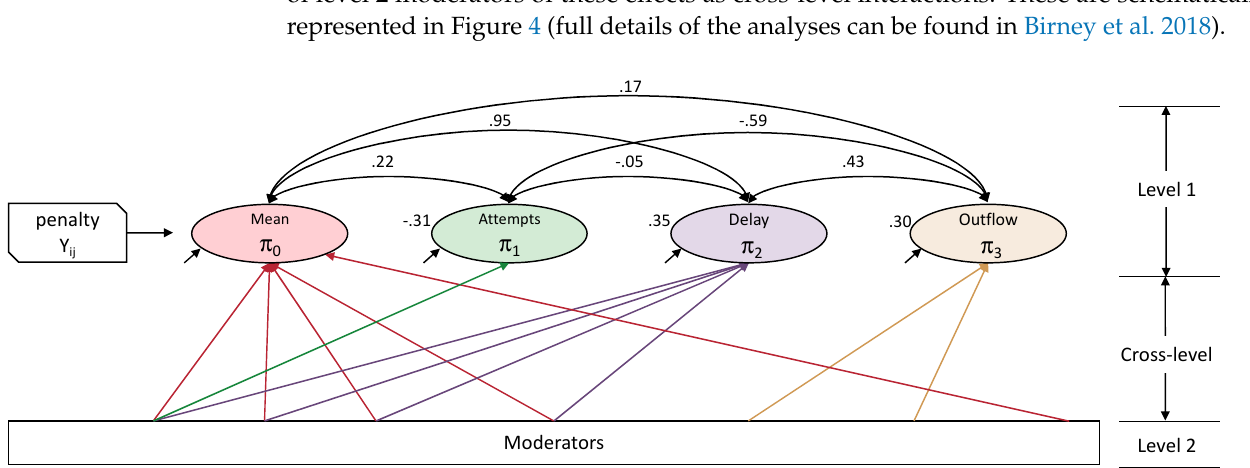
analyses. The values by the curved arrows are the correlations between fixed-effects in a baseline model (i.e., without moderator variables). Moderators (cross-level interactions; β 01 , β 11 , β 21 , and β 31 ) included reasoning (verbal, numerical, abstract), personality (five-factor model), mindsets (goal orientations and implicit theories), and emotional intelligence (MSCEIT branches). See Birney et al. (2018) for details of additional covariates that were